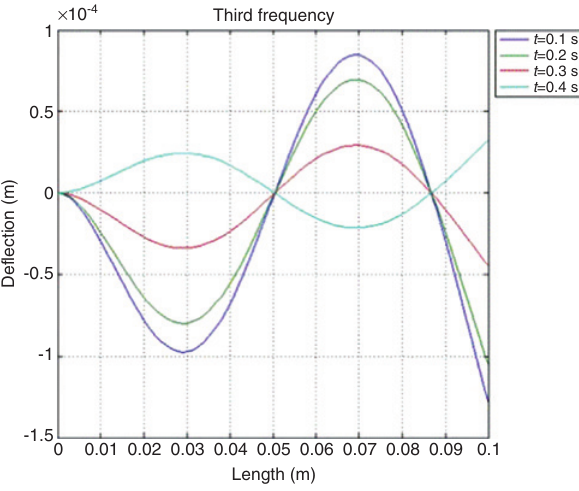
Figure 5: Vibrations of third characteristic mode of the cantilever